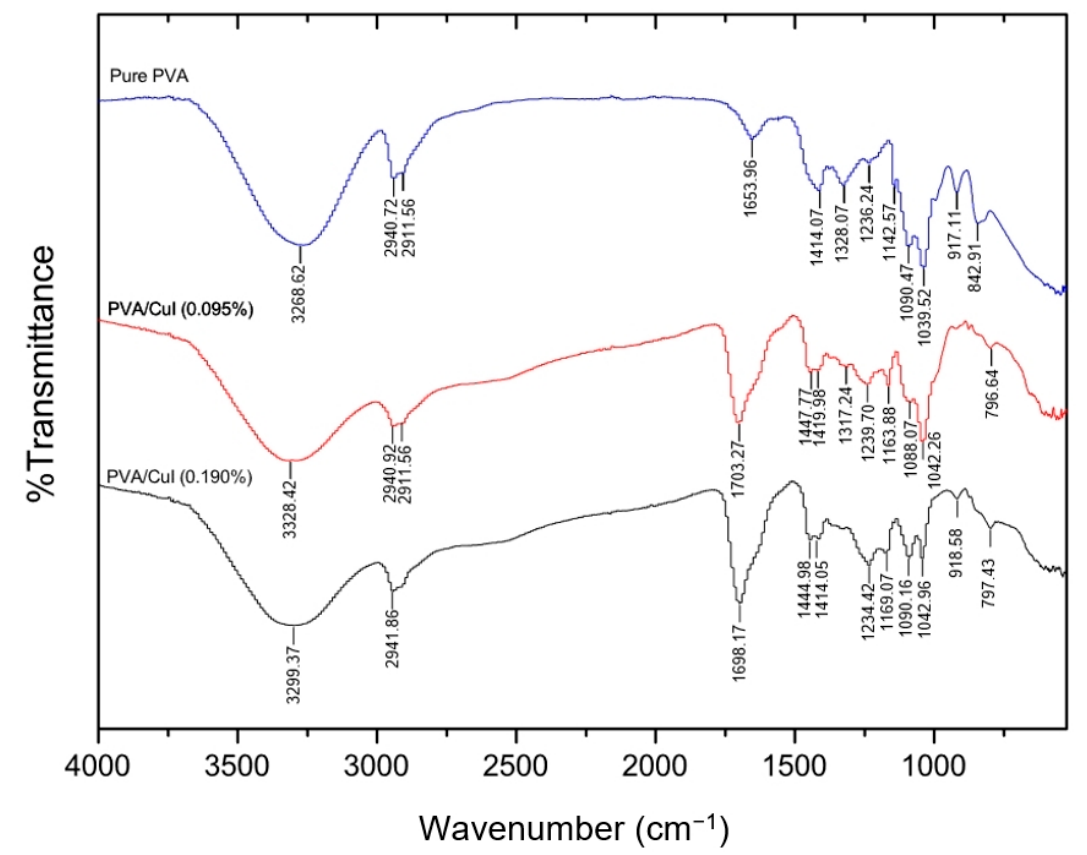
Figure 9. FTIR spectra of PVA and PVA incorporating CuI suspension. Table 3. Wave numbers of FTIR results for PVA and PVA loaded with CuI suspension.